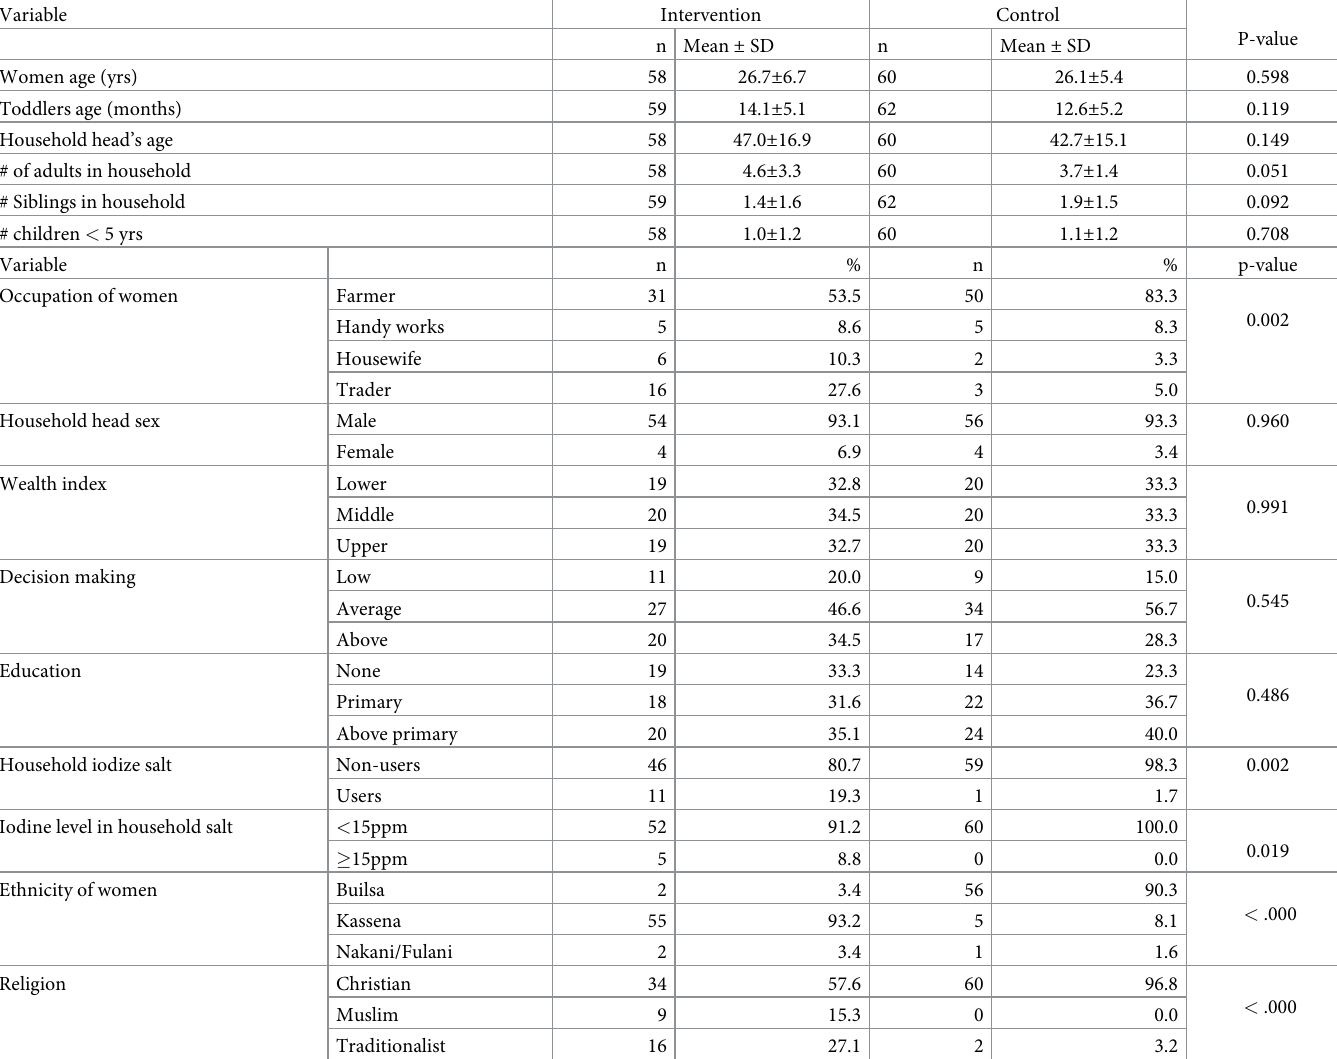
Table 1. Demographic characteristics of child-bearing age women (15–49 yrs) and their toddlers (6–23 mo) in intervention and control groups at